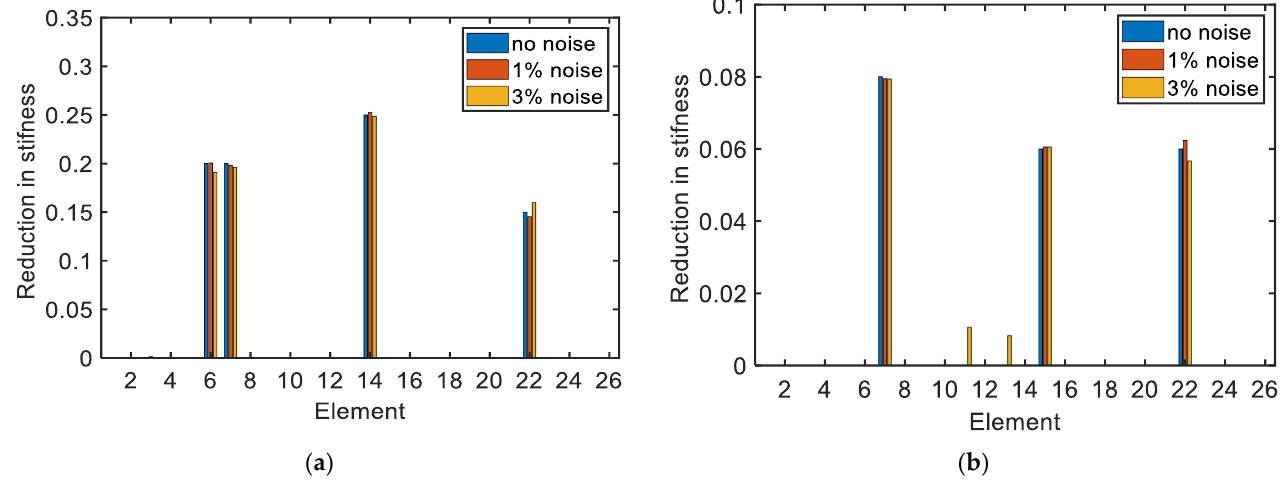
Figure 12. ( a ) The identification results of complex damage cases. ( b ) The identification results of small damage cases. Table 5. The identification results of two damage cases by MDBA in different noise levels. Damage Case Noise Level